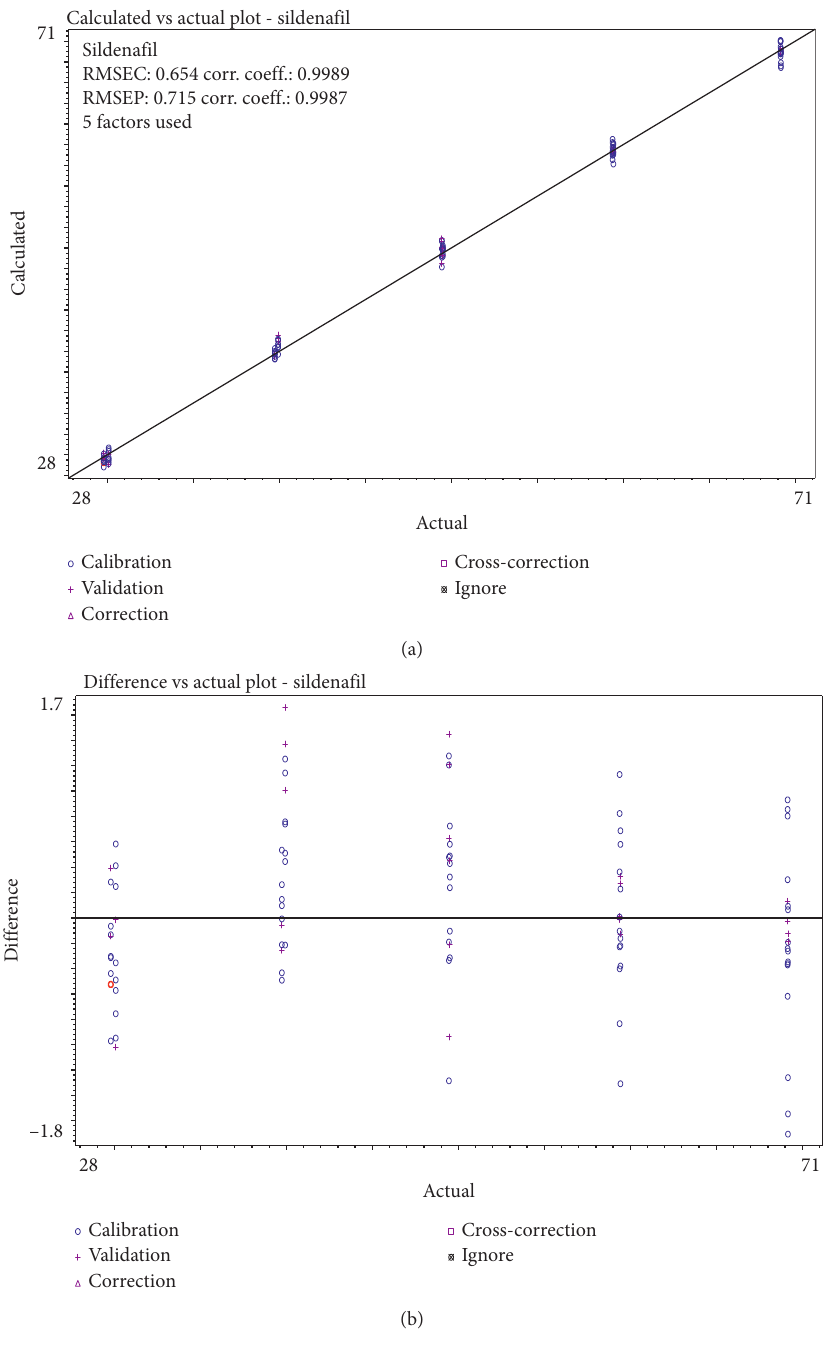
Figure 3: Calibration model: (a) regression curve and (b) residual